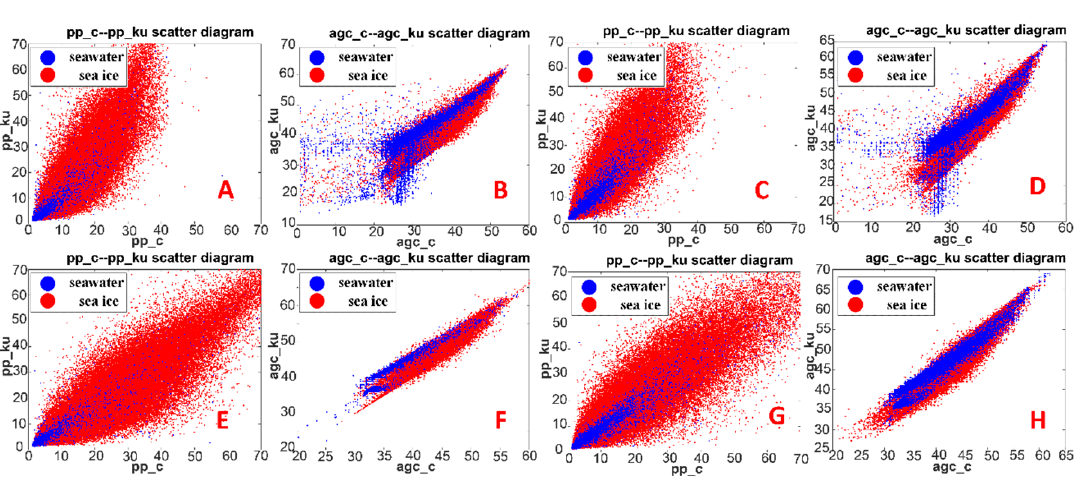
Table 2. Threshold segmentation.